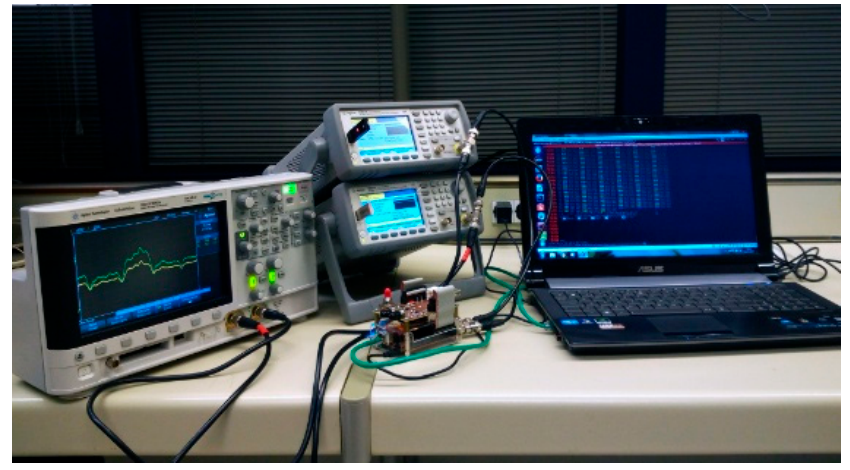
Figure 10. Validation test bench.